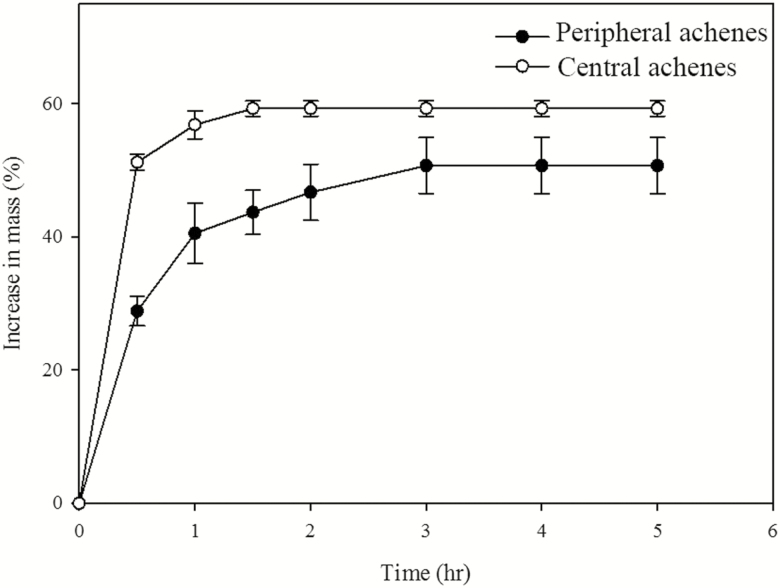
Imbibition curves for peripheral and central achenes of Bidens pilosa. Error bars are ±SE.